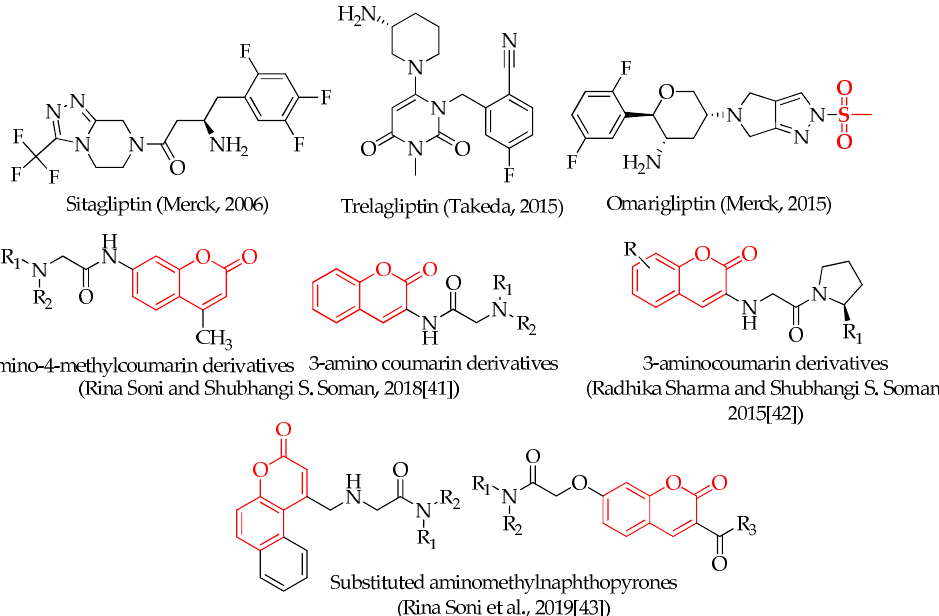
Figure 1. Structures of some approved drugs and coumarin derivatives reported by different re- searchers as DPP-IV inhibitors.